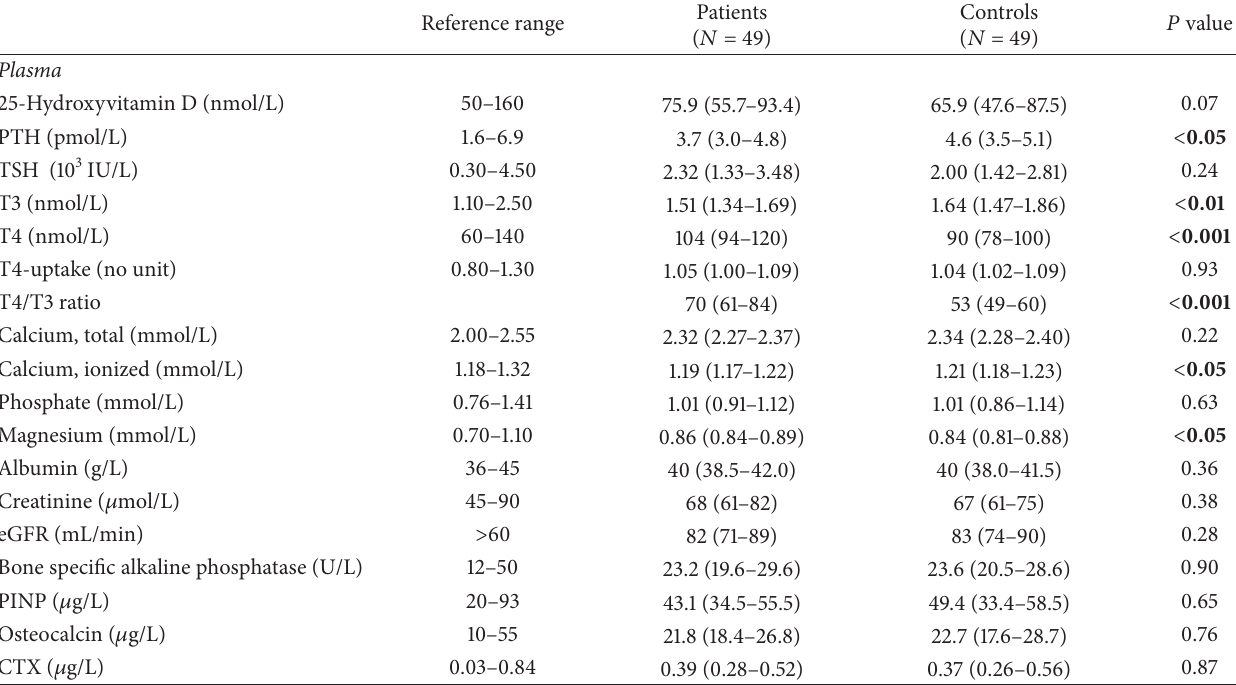
Table 2: Biochemical characteristics of included patients on long-term treatment with levothyroxine and matched controls. Median with interquartile (25%–75% percentiles) range.